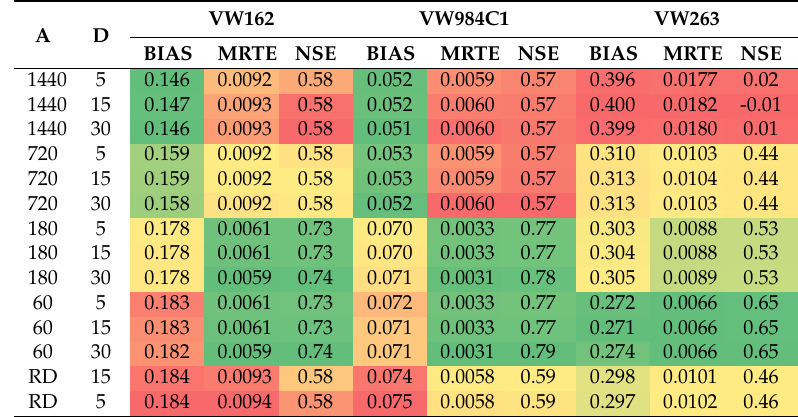
Table 7. The three indicators (bias, Mean Root Transformed Error—MRTE, and Nash-Sutcliffe Efficiency—NSE) are reported for the 14 products indicated with accumulation resolution (A) and downscaling resolution (D) in minutes, for the three measurement locations. Radar products are indicated with RD. A conditional colour formatting is applied to easily compare the values, where green is a positive performance, and red a negative one.